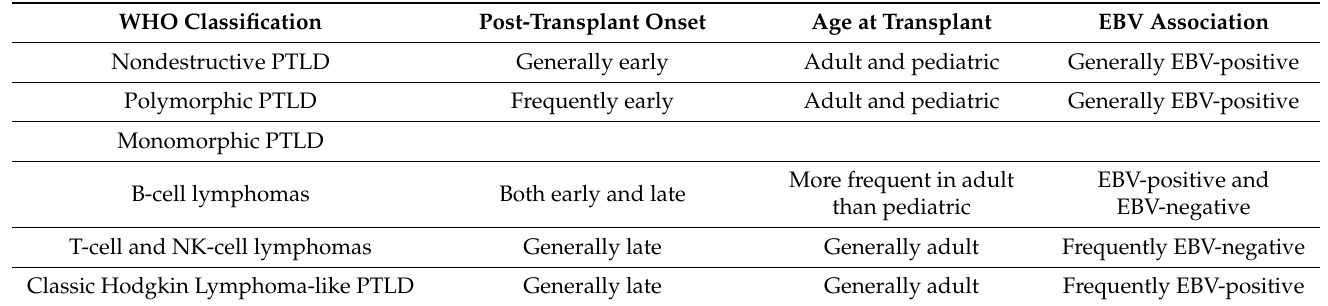
Table 1. Characteristics of EBV-positive and EBV-negative